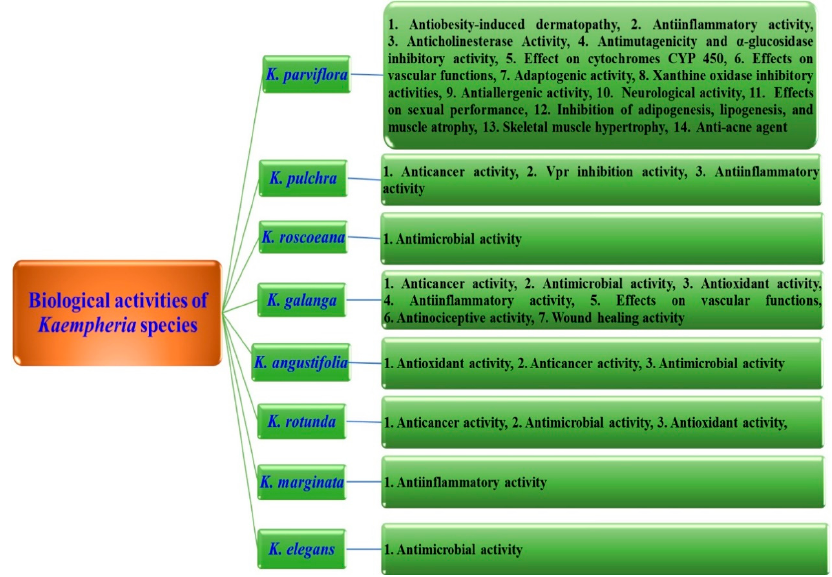
Figure 2. Reported biological activities for Kaempheria species.